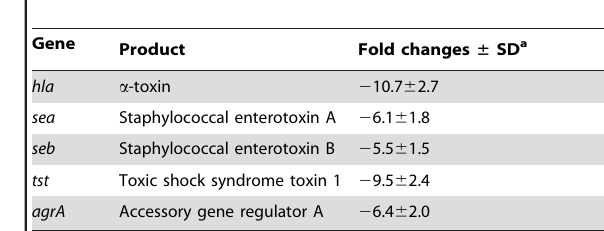
Table 3. Relative gene expression levels of hla , sea , seb , tst and agrA in S. aureus ATCC 29213 after treatment